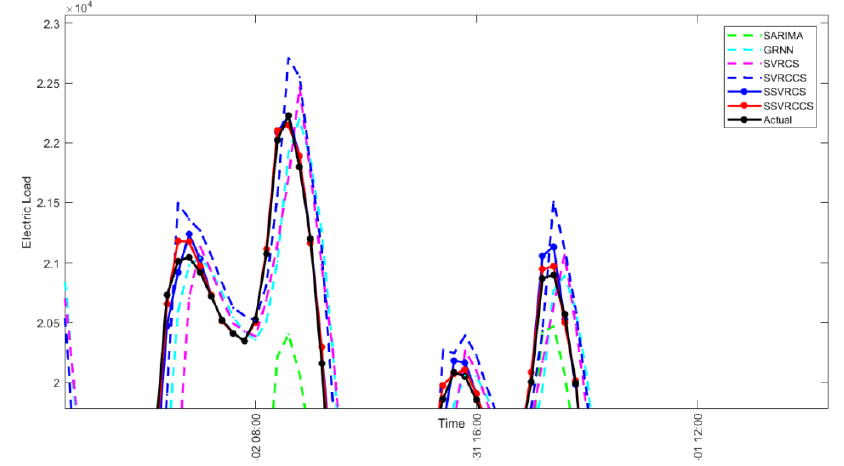
Figure 13. The enlargement comparison of Peaks 5 and 6 from the compared models for Example 2. Energies 2018 , 11 , x 17 of 21